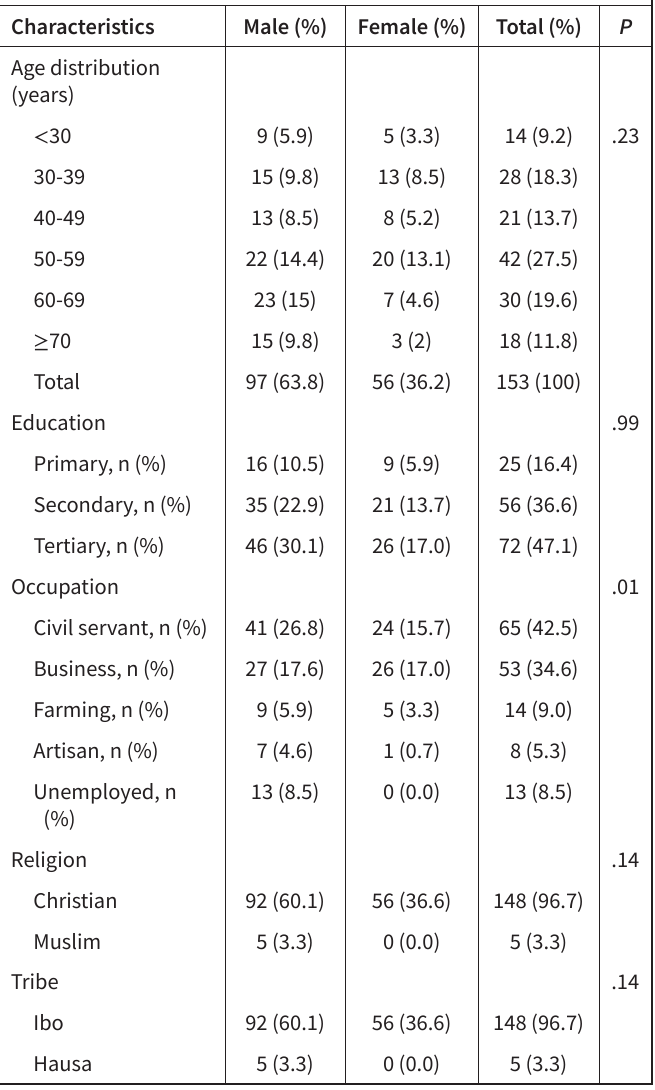
Table 1. Demographic